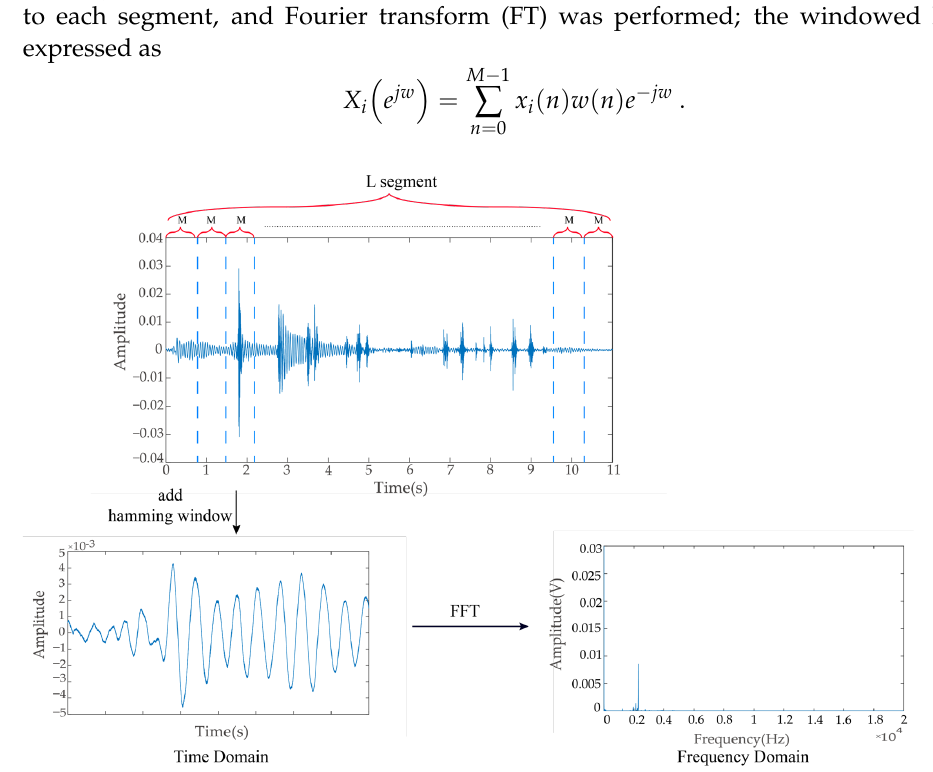
Figure 2. Schematic diagram of the fast Fourier transform of ingestion acoustic signal. (cid:0) (cid:1) The power spectrum of each segment I i may be expressed as